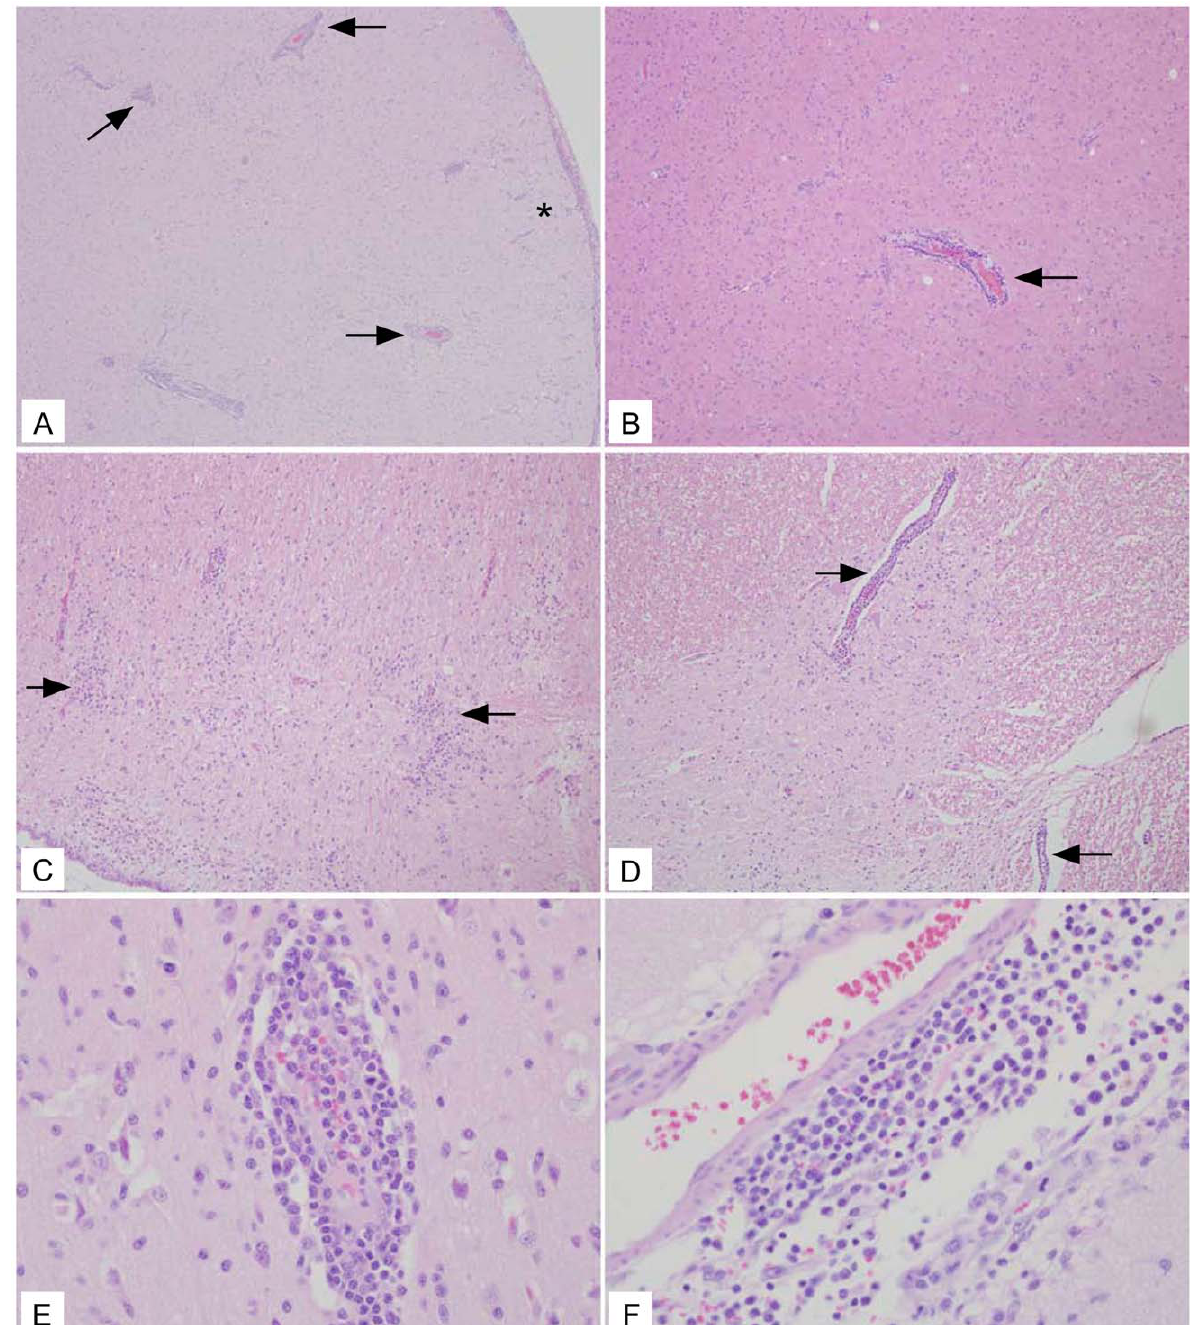
Figure 3. Representative rVSV-wt histology showing lesions in all neural tissue examined. (A) Frontal cortex (10 6 ) section with severe encephalitic changes including perivascular lymphohistocytic cuffs (arrows) and aggregates of lymphocytes in the neuroparenchyma (*). (B) Frontal cortex (10 6 ) section with perivascular cuff of lymphocytes and histocytes (arrow). (C) Cerebellum (10 6 ) section with aggregates of lymphocytes in the parenchyma (arrows) admixed with increased numbers of reactive glial cells. (D) Spinal cord (10 6 ) section with gliosis admixed with regions of perivascular inflammation (arrows). (E) Frontal cortex (40 6 ) section depicting large numbers of perivascular lymphocytes and histocytes infiltrating into the adjacent gray matter. (F) Basal ganglia (40 6 ) section depicting large numbers of lymphocytes and histocytes both around a meningeal vessel and invading into the adjacent tissue.